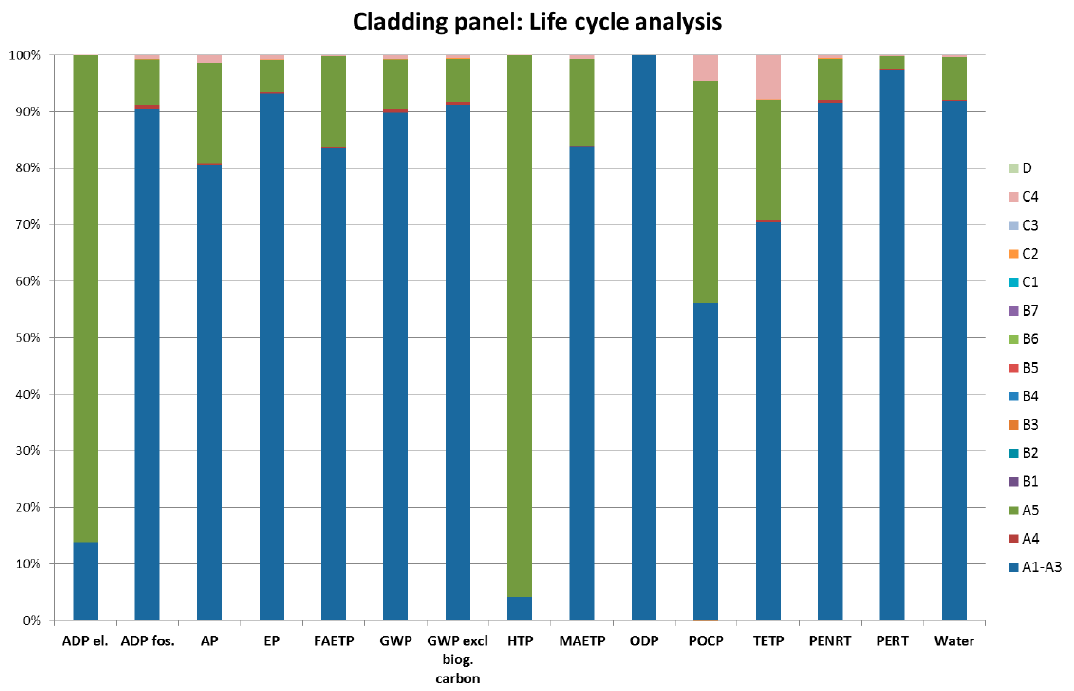
Figure 4. The environmental impacts associated with different life cycle stages of the prefabricated geopolymeric façade cladding panel (the figure was produced by the authors).